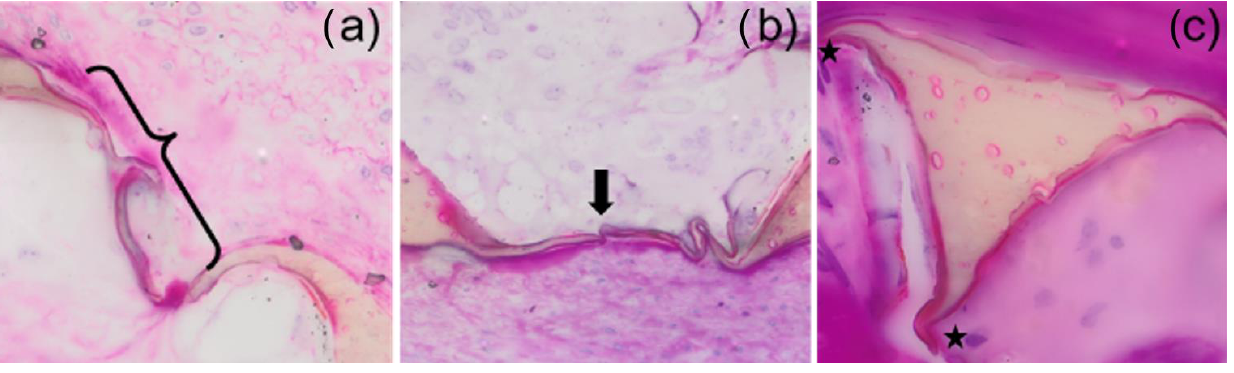
Figure 4. SMP foam trans-sections show the membranes at high resolution. Intact membranes (( a ), bracket) were counted throughout the entire visible section. Membranes visible but broken (( b ), black arrow) were counted separately to showcase the gradient of degradation. Finally, strut absent membranes at vertices (( c ), stars) are identified as missing membranes. Tissues were stained with hematoxylin and eosin (H&E).